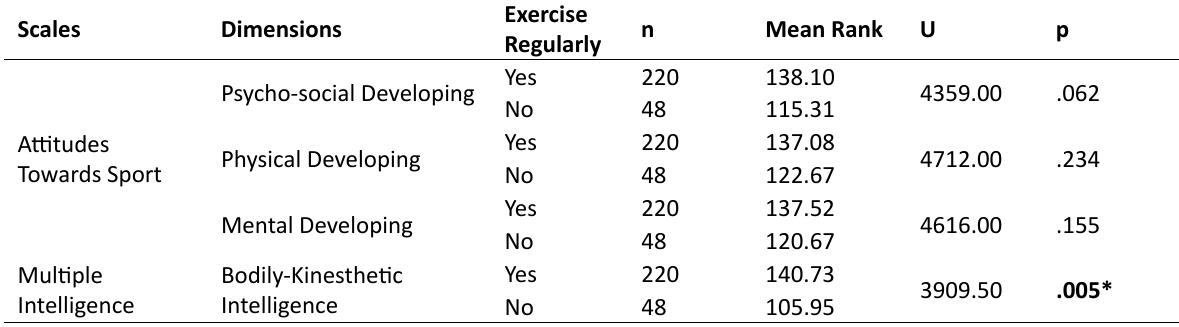
Table 6. Evaluation of the students’ attitudes towards sport and bodily-kinesthetic intelligence by exercise regularly Scales